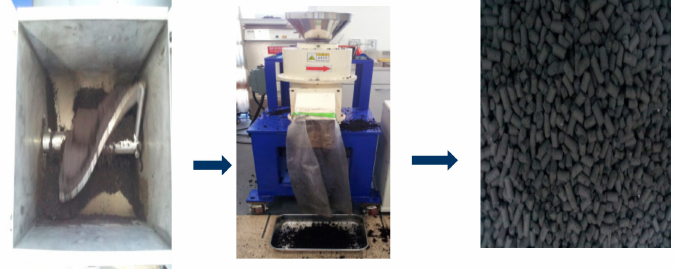
Figure 1. Processing diagram of the biochar pellet with different combinations of biochar and pig manure compost described by Shin et al. (2018)